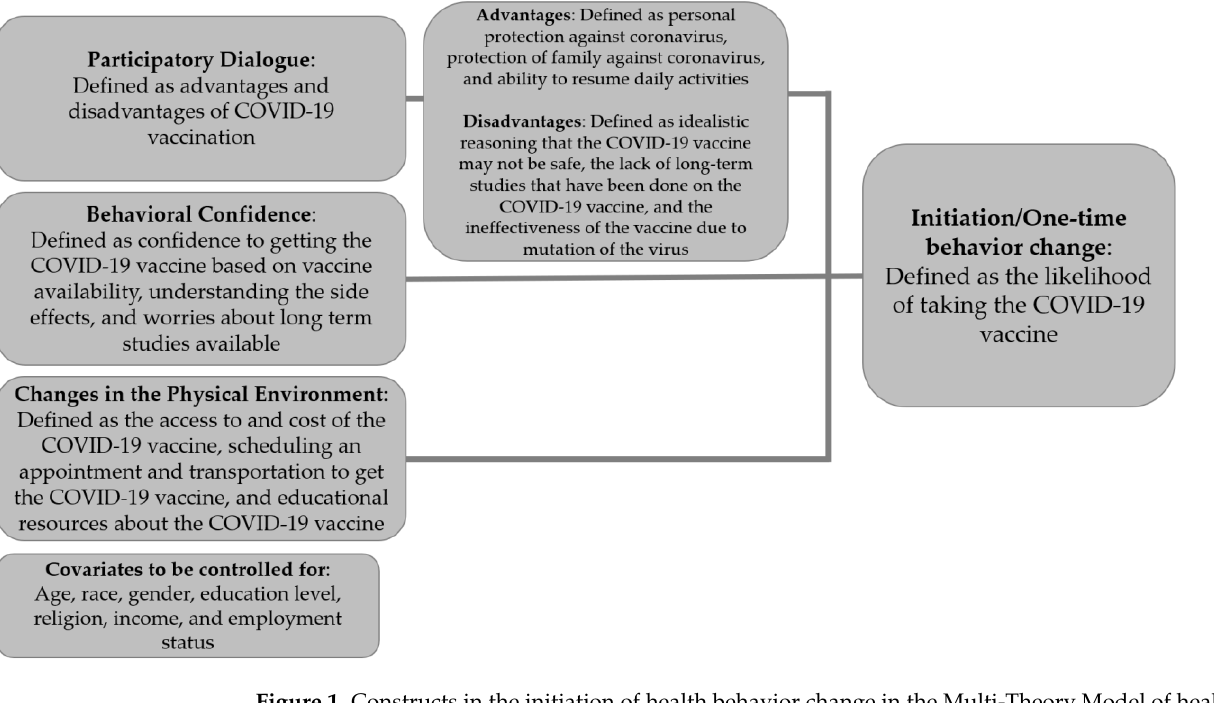
Figure 1. Constructs in the initiation of health behavior change in the Multi-Theory Model of health behavior change.